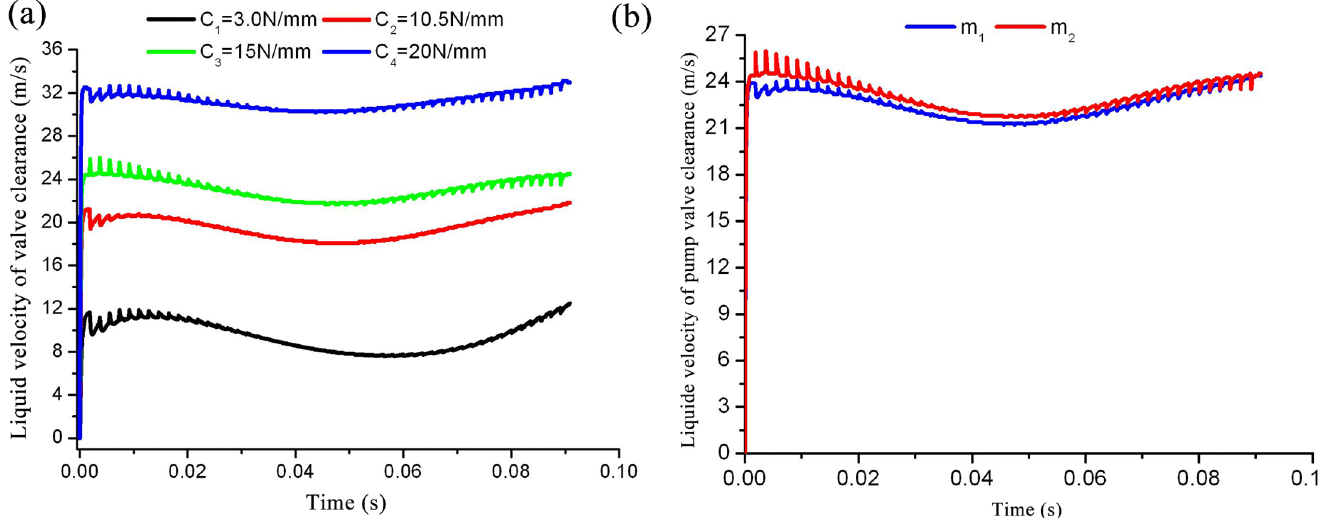
Fig 13. Curve of fluid velocity of valve clearance as a function of time. a) Fluid velocity curves of different spring stiffnesses; b) fluid velocity curve of different valve masses.